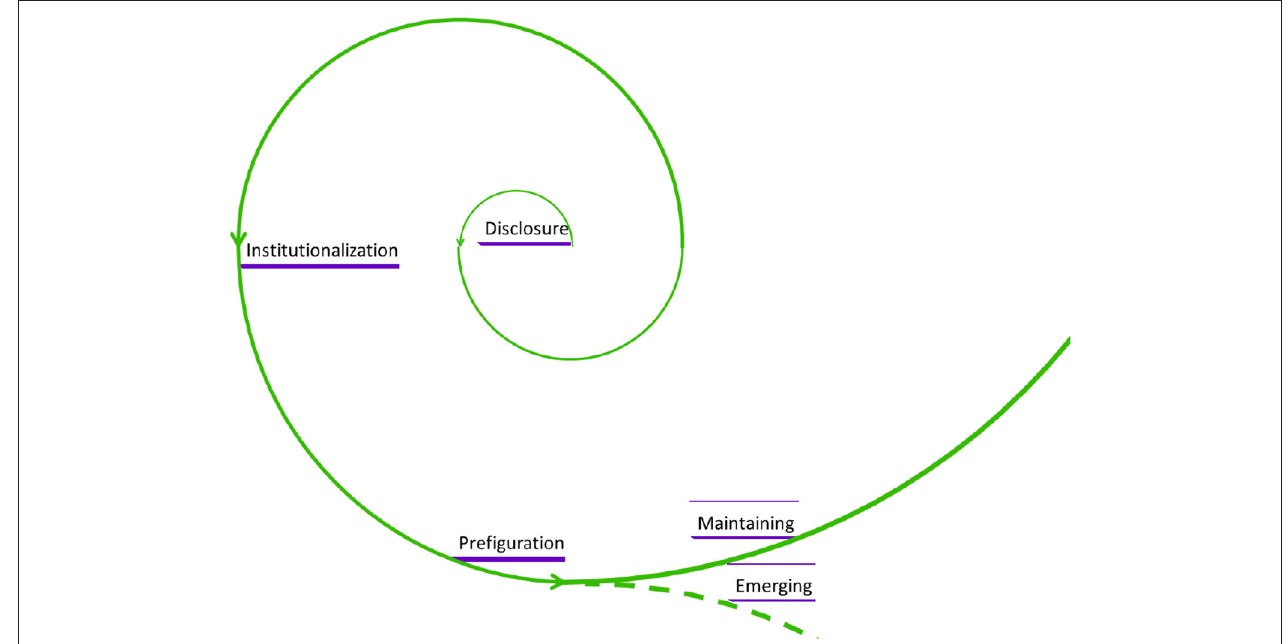
FIGURE 1 | Cycle of urban commons